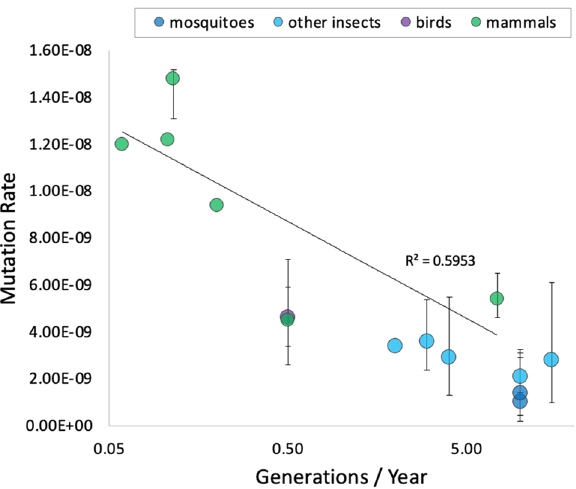
Figure 2. Mutation rate estimation and number of generations per year. Plot of number of generations per year (x-axis) against mutation rate estimations (y-axis) for six species of mammals, green circles ( Canis lupus , Mus musculus , Chlorocebus sabaeus , Gorilla gorilla , Pan troglodytes and Homo sapiens ), a bird, violet circle ( Ficedula albicollis ), the two species of mosquitoes estimated in this study, blue circles and five non-mosquito insects